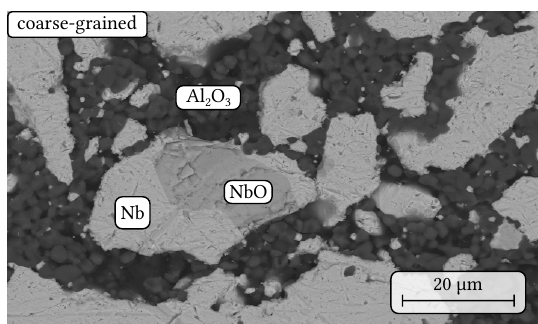
Figure 10. SEM micrograph in BSE contrast showing similar phase assemblage as the fine-grained composite with niobium particles containing niobium oxide impurity within a fine-grained alu- mina